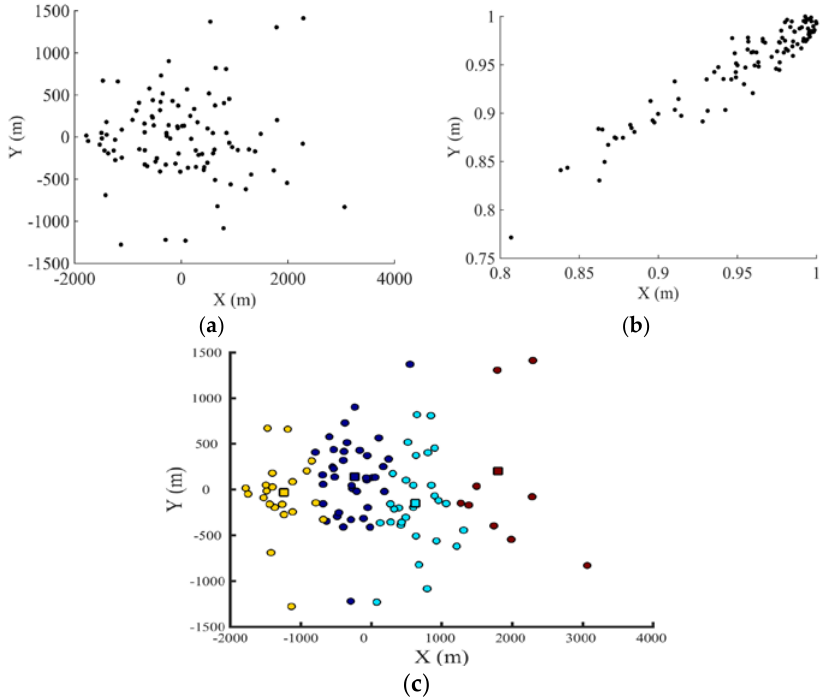
Figure 7. Scenario reduction analysis for the E m 100 realisations resulting in: ( a ) a two-dimensional (2D) spatial representation of the E m 100 realisations (black points) using the Euclidean distance computed (X and Y represent the distances of the Dissimilarity matrix); ( b ) a 2D Feature space representation for the E m 100 realisations (black points); and ( c ) the clusters’ final configuration (coloured points) with the matching medoids (coloured squares) for four clusters.